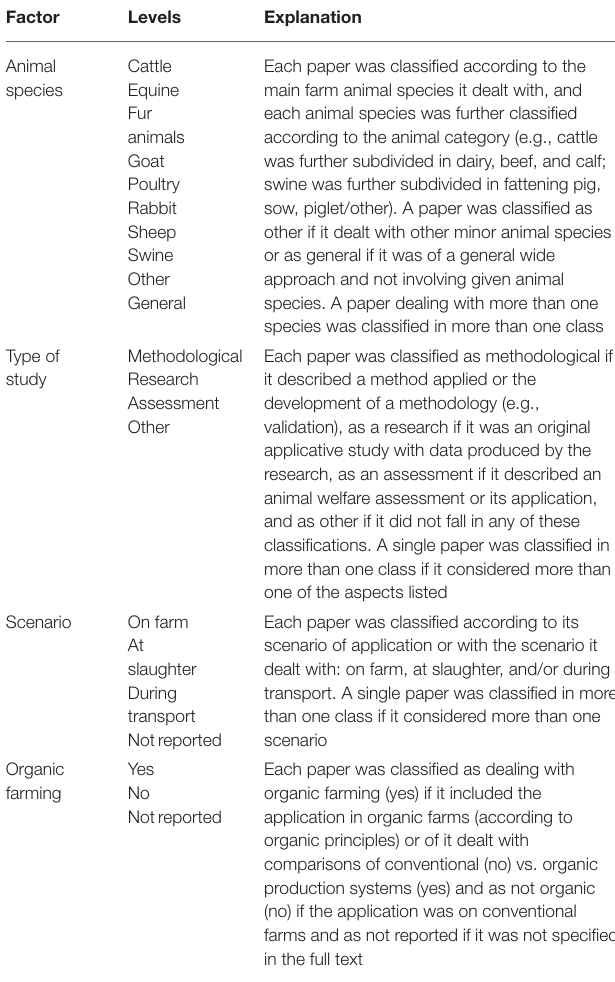
TABLE 1 | Factors used to classify the papers, the different levels, and the explanation of how each paper was